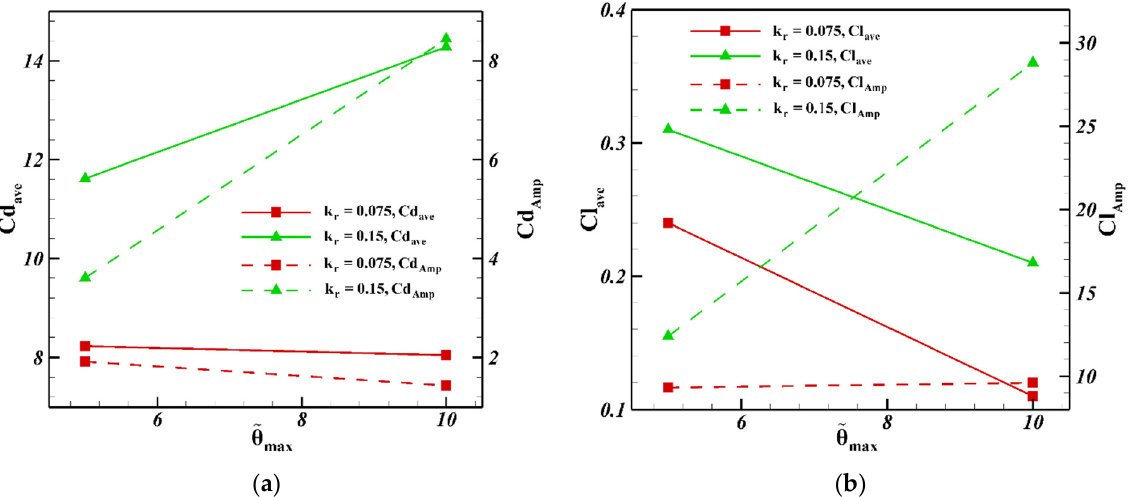
Figure 11. The variation curve of the lift-drag coefficient with the oscillation amplitude under the same oscillation frequency. ( a ) drag coefficient. ( b ) lift coefficient.